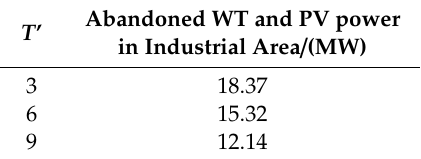
Table 9. Abandoned WT and PV power in the industrial area under different adjustable heating